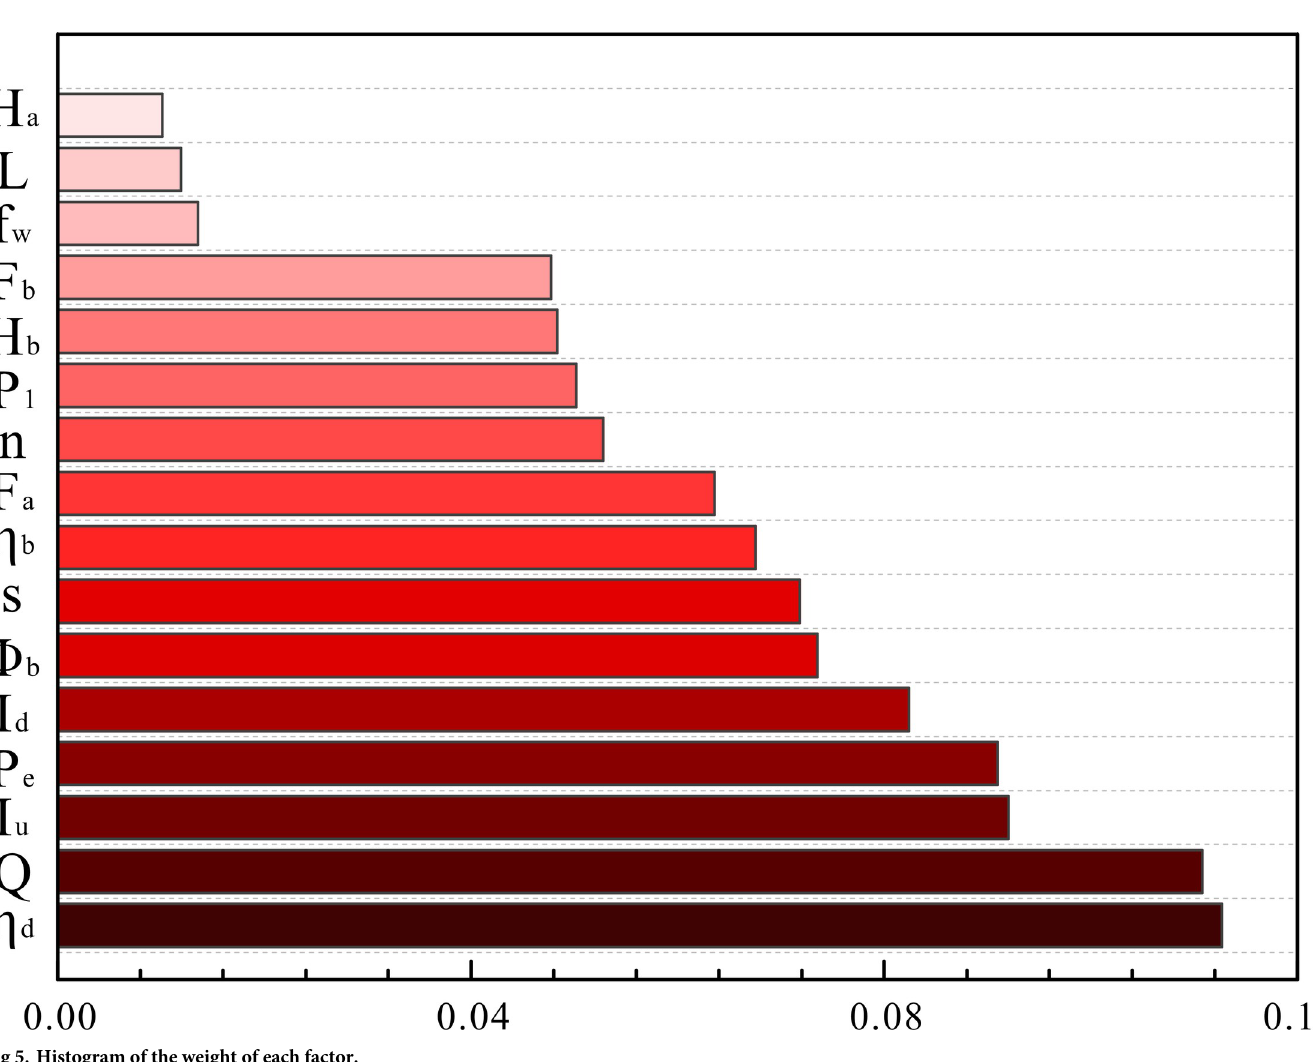
clustering algorithm and the original k-means algorithm are compared and analysed, as shown in Fig 7. It can be seen that the clustering results of the improved algorithm are better than those of the k-means algorithm. The results of the improved algorithm overlap less and the boundaries of the categories are more distinct. It can be seen from Fig 7(A) that the overall conformity with the expected assumptions only has a small overlap. The system efficiency dimensionless values of the four groups are 1.165, -0.164, -0.166 and -0.636. The second and third groups can be collectively referred to as normal wells. The proportions of high-efficiency, normal and low-efficiency wells are 27.64%, 29.76% and 42.6%, respectively–this does not dif- fer much from the original data. As can be seen in Fig 7(B) and Fig 7(D), the clustering effect is not ideal, and there is significant overlap between different groups. It can be seen from Fig 7 (C) that the clustering effect is improved. The dimensionless values of the system efficiency in the four groups are 1.11, -0.123, -0.584 and -0.936, and their proportions are 30.45%, 18.12%, 47.04% and 4.39%, respectively, which differ from the original data.